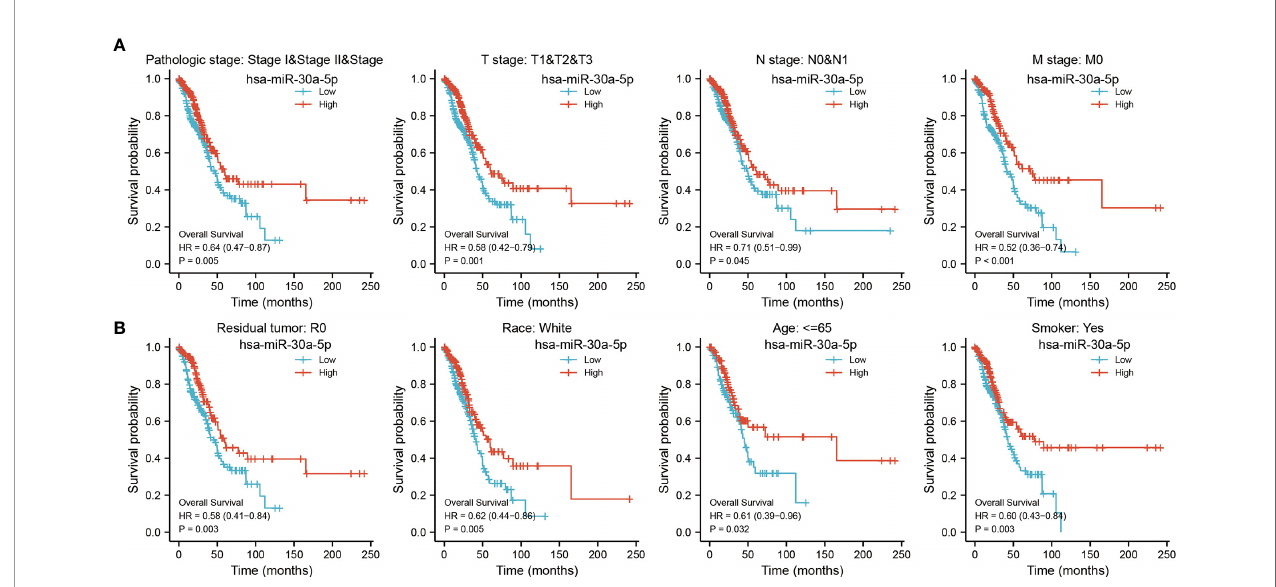
FIGURE 6 | Prognostic value of differential expression of miRNA-30a-5p in different subgroups. Prognostic value of miRNA-30a-5p in diverse subgroups, including (A) pathologic stage and TNM stage, (B) smoking, residual tumors, age, and ace. CR, complete response; PR, partial response; SD, stable disease; PD, progressive disease.